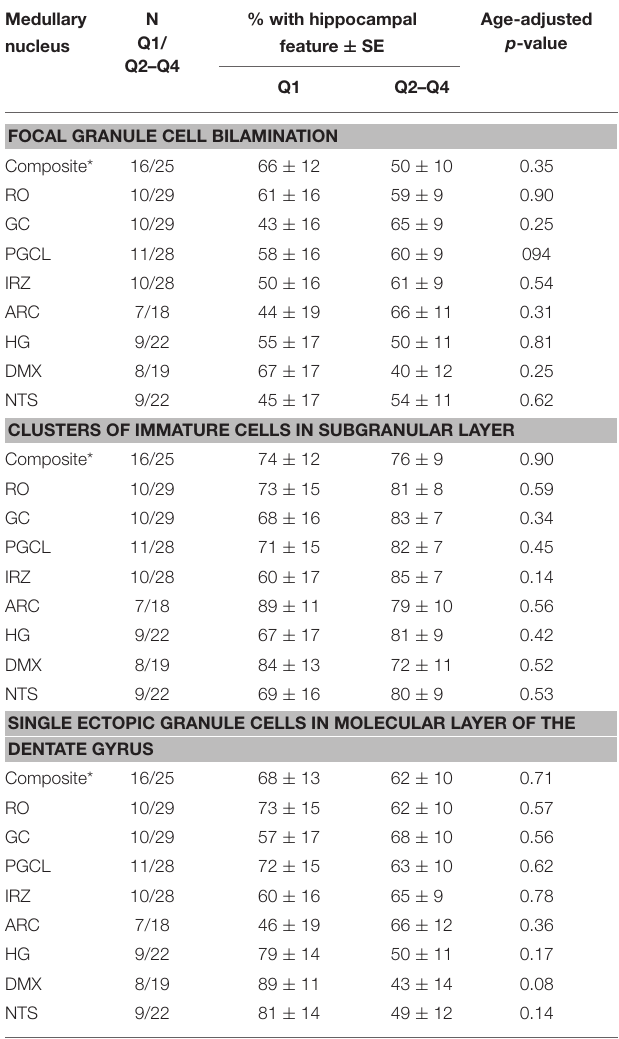
TABLE 6 | Estimated age-adjusted prevalence of hippocampal abnormality in SIDS cases with low (first quartile) vs. higher 5-HT 1A binding (quartiles 2–4).